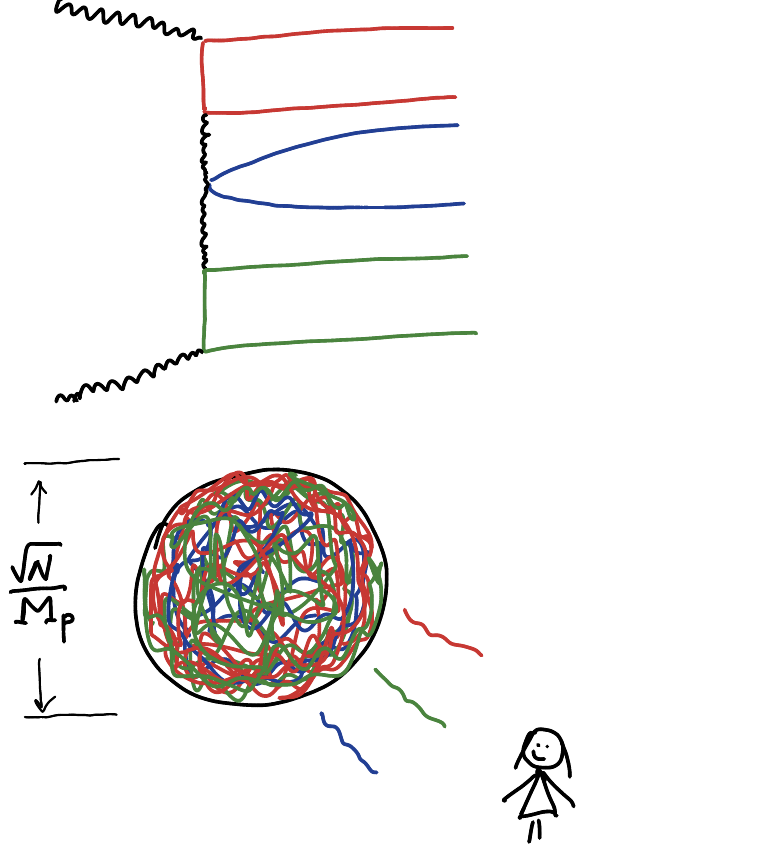
Figure 3 . Above, 2 → n process in which two initial gravitons produce n particles of different species denoted by different colors. The process saturates unitarity at the species scale Λ UV ∼ M P √ Below, Alice observing a smallest semi-classical black hole which carries the species hair (denoted by